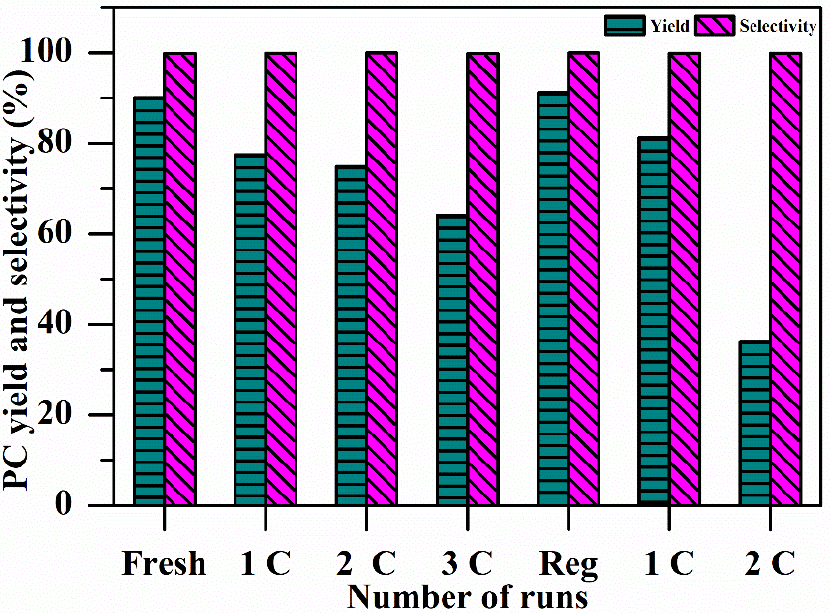
Figure 6. Effects of catalyst reusability on the yield and selectivity of PC. Conditions: catalyst 2 wt.%, reaction time 4 h, PG/urea ratio 3:1, reaction temperature 160 °C.